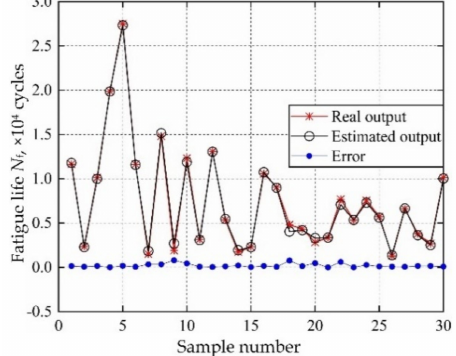
Figure 18. Prediction results of collaborative IKM.